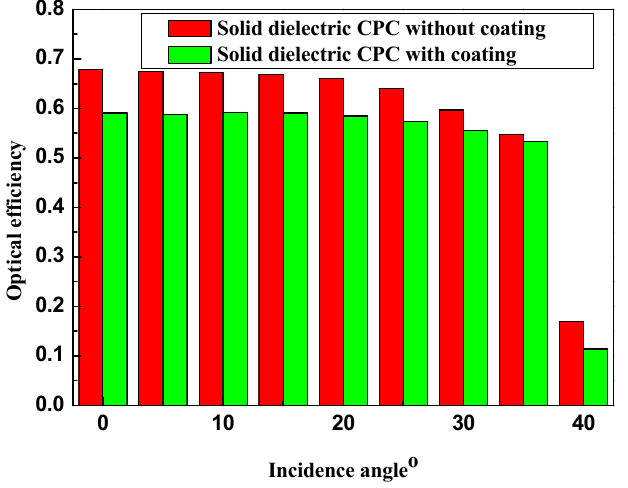
Figure 10. Optical efficiency of the truncated solid dielectric CPC with and without mirror coating at different incidence